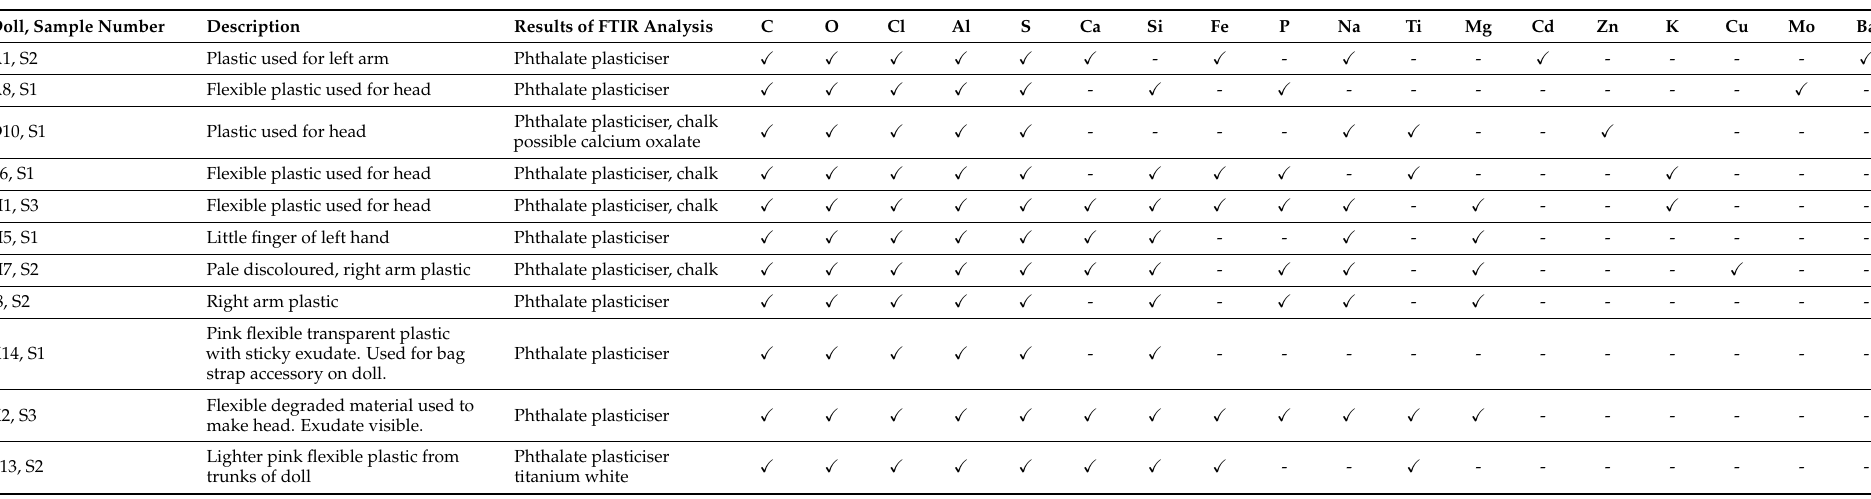
Table 4. Summary of FTIR results, and elemental composition via EDX of samples identified as PVC. Samples were taken from 11